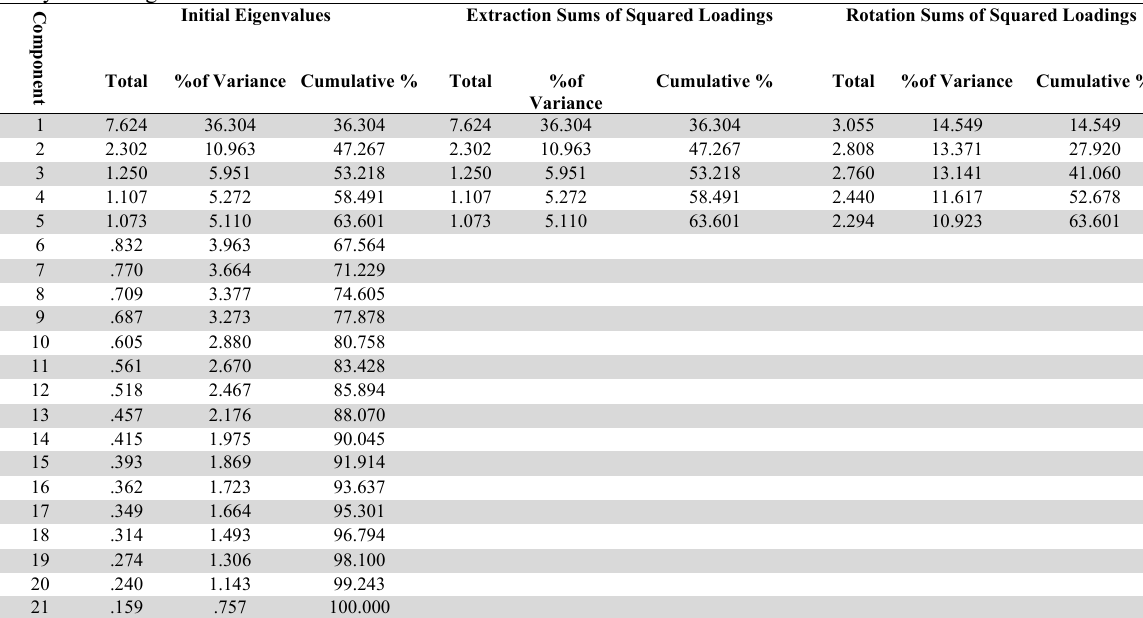
Analysis of the gross variance extracted elements